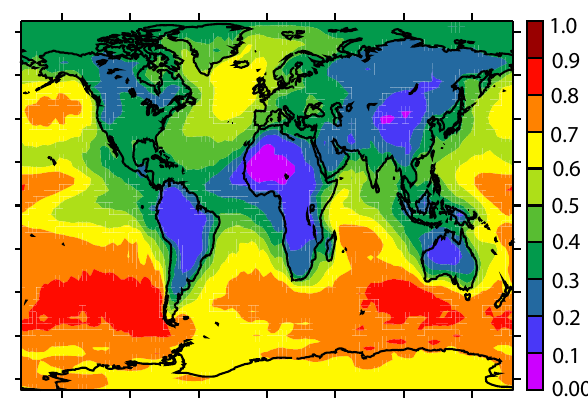
Fig. 1. Annual mean distribution of κ at the surface simulated by EMAC.